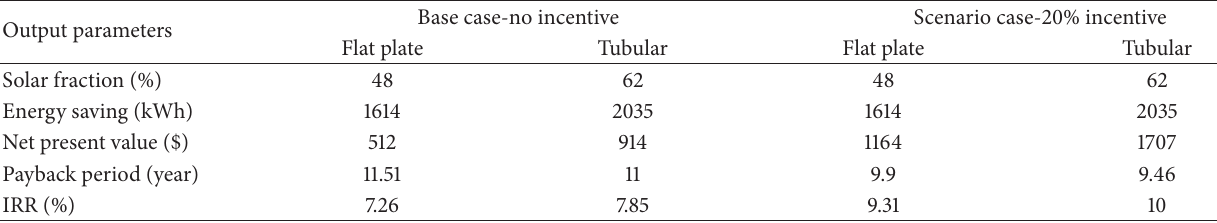
Table 3: Annual energy savings and economic